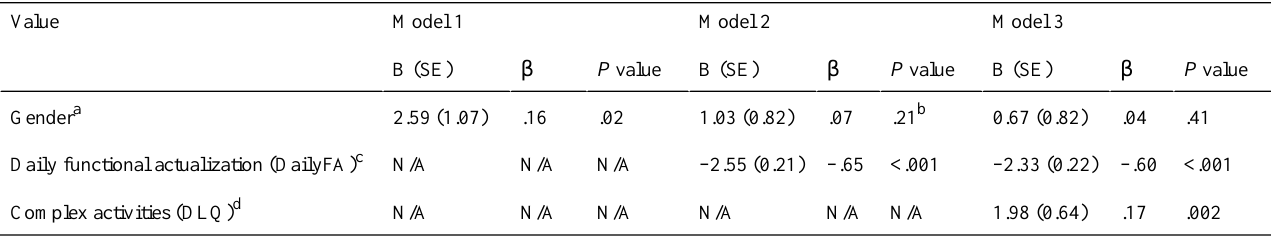
Table 4. Predicting state anxiety from gender, daily functional self-actualization, and functional cognition.